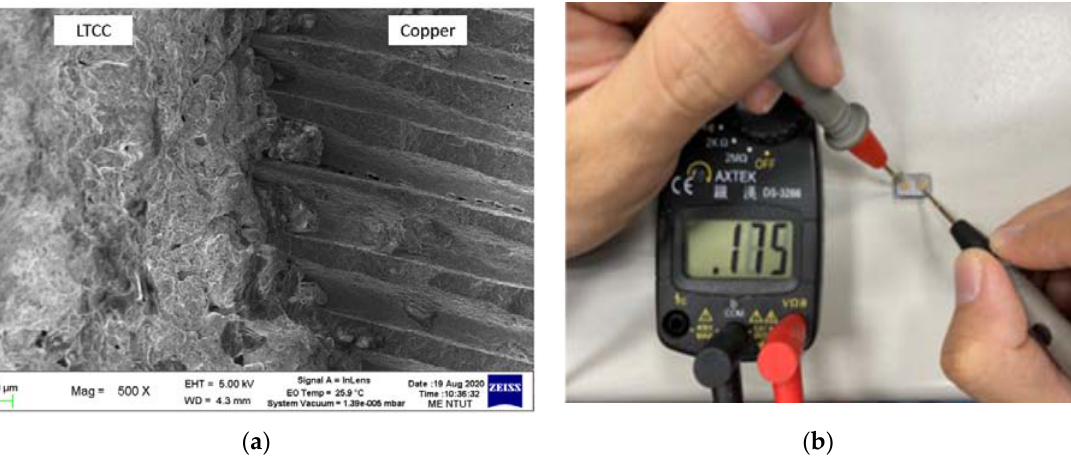
Figure 12. SEM image of the microstructure of the interface between the LTCC ceramic and copper ( a ) and the electrical conductivity test ( b ).